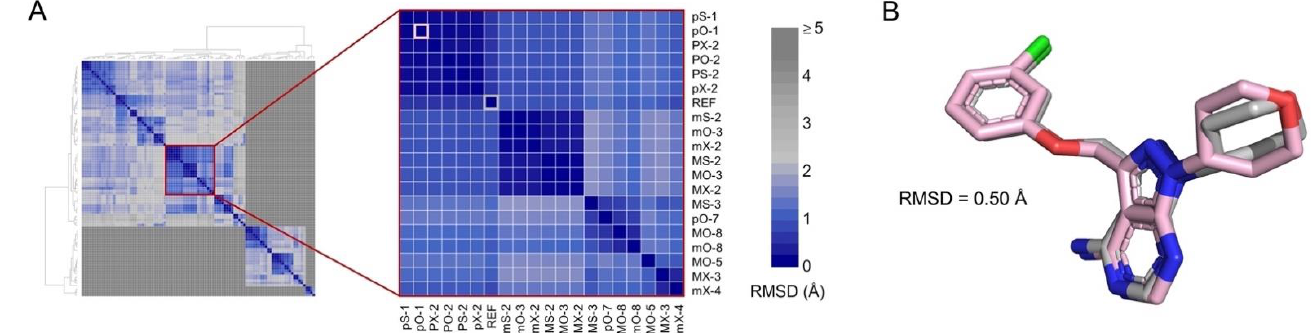
IC50s were obtained using peptide PLSRTLpSVASLPGL a , GST-p53 b , or α -Casein c as substrates.